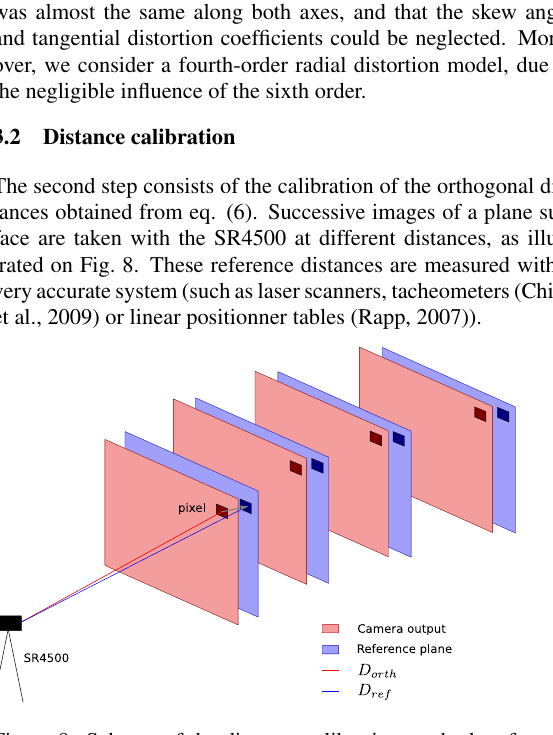
Figure 8. Scheme of the distance calibration method: reference distances are drawn in blue and SR4500 outputs are in red